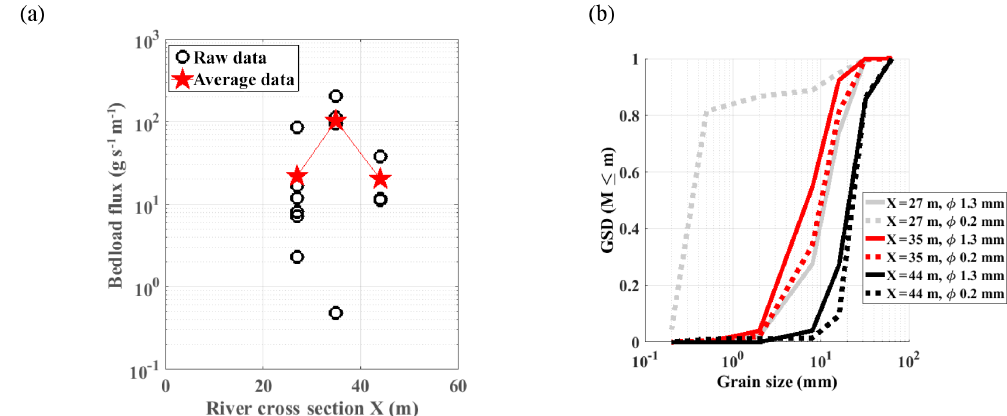
Figure 8. Measured bedload flux in three positions across the Isère River, X = { 27 , 35 , 44 } m and (b) measured GSD curves in these positions, using the TR sampler with two mesh sizes, 0.2 and 1.3mm.